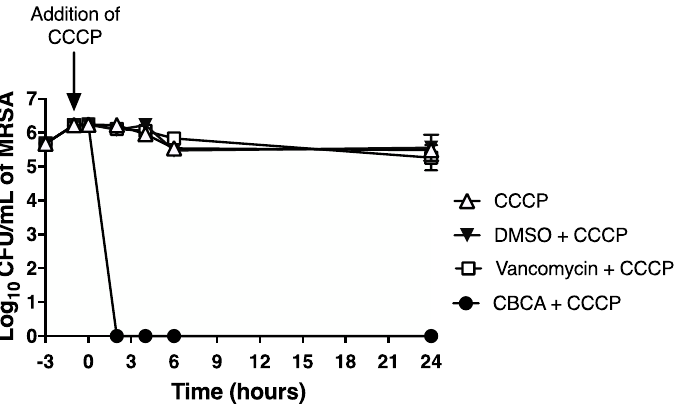
Figure 2. Time-kill assay of carbonyl cyanide m -chlorophenylhydrazone (CCCP)-treated MRSA. MRSA were grown to OD 600 0.001 and pre-treated with the proton-ionophore CCCP (10 µ M) for 1 h to arrest growth. Bacteria were then treated with CBCA (40 µ M) or vancomycin (30 µ M) for 24 h. At indicated time points aliquots of cultures were retrieved and subjected to serial dilution and plating for enumeration of viable bacteria (CFU / mL). Error bars represent the standard error obtained from triplicate samples. Data representative of two independent experiments.